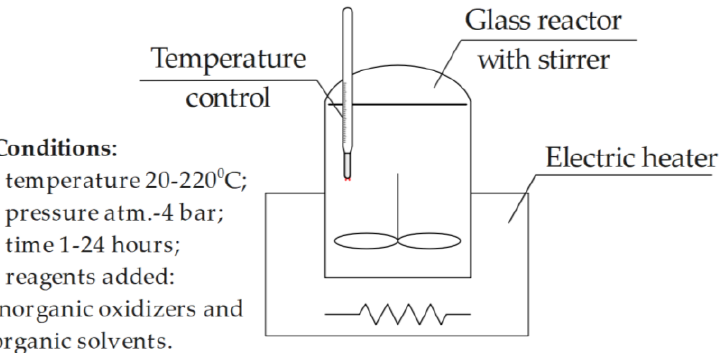
Figure 1. Experiment scheme of carbon fiber extraction in the process of solvolysis. Samples were cut with a hand saw before loading into the